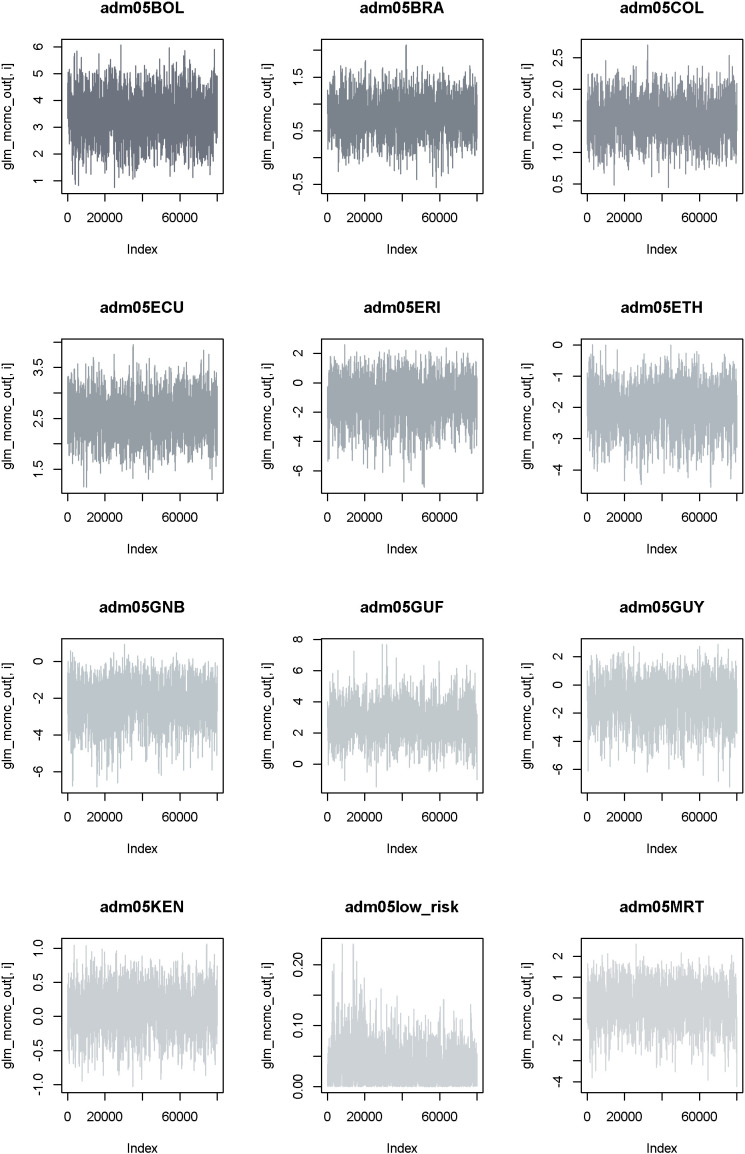
Trace plots from estimation of model variant 17 as an example of convergence.